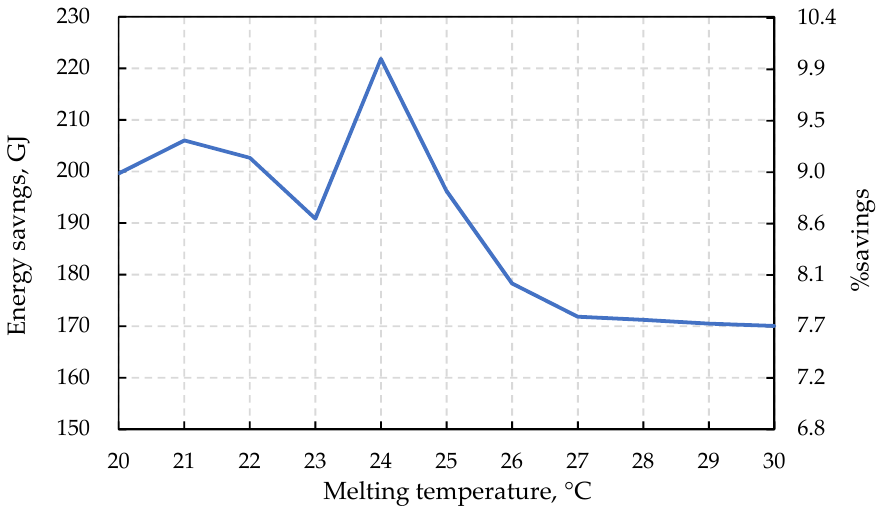
Figure 10. Optimization of PCM melting temperature.